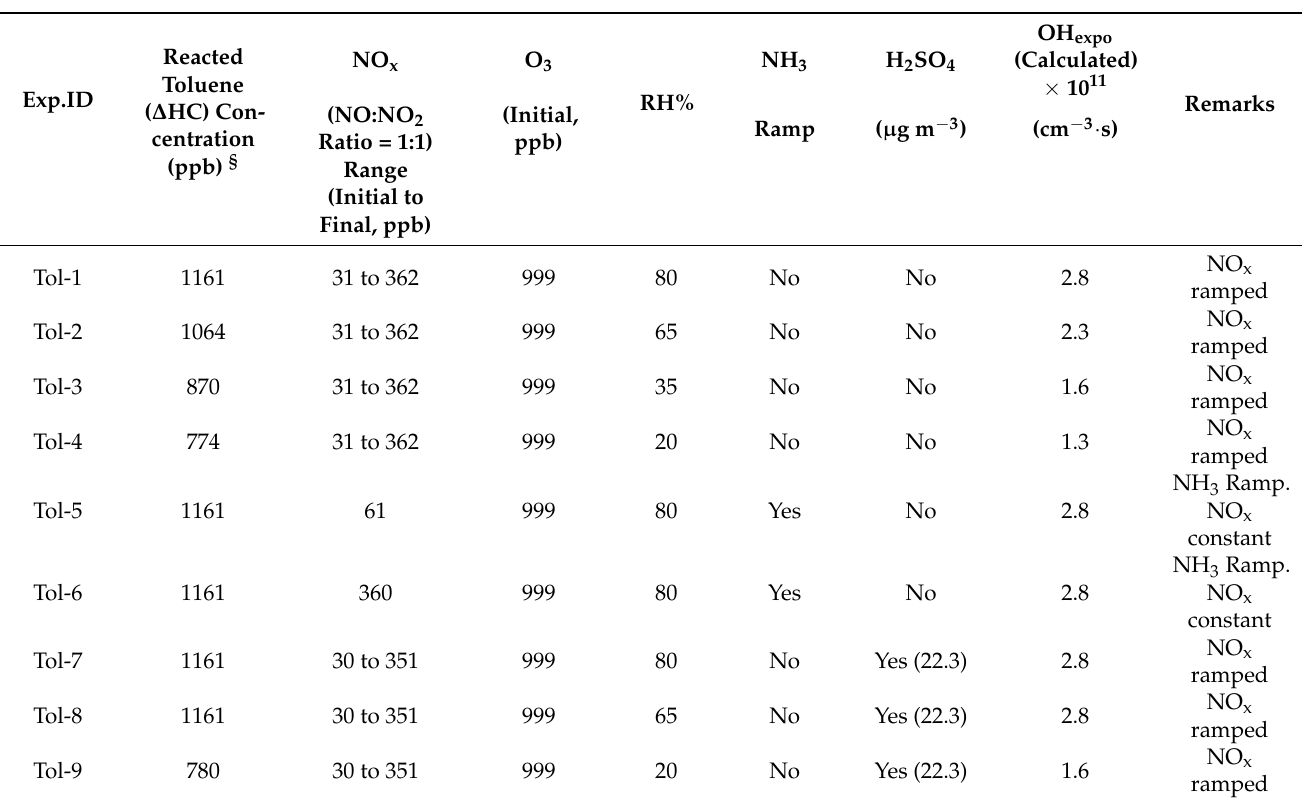
Table 1. The experimental input